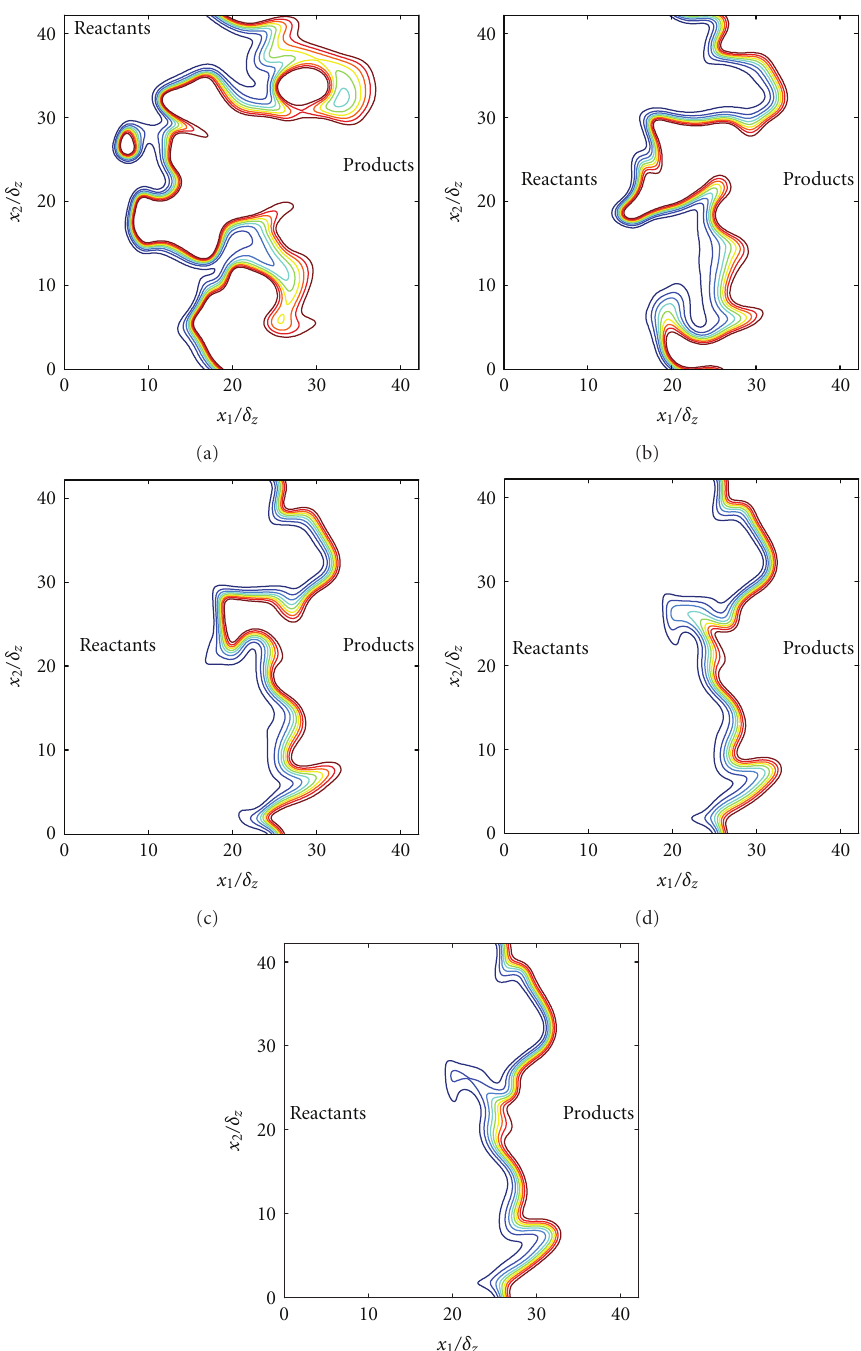
Figure 2: Contours of c in the x 1 − x 2 midplane at time t = δ th /S L for (a–e) cases